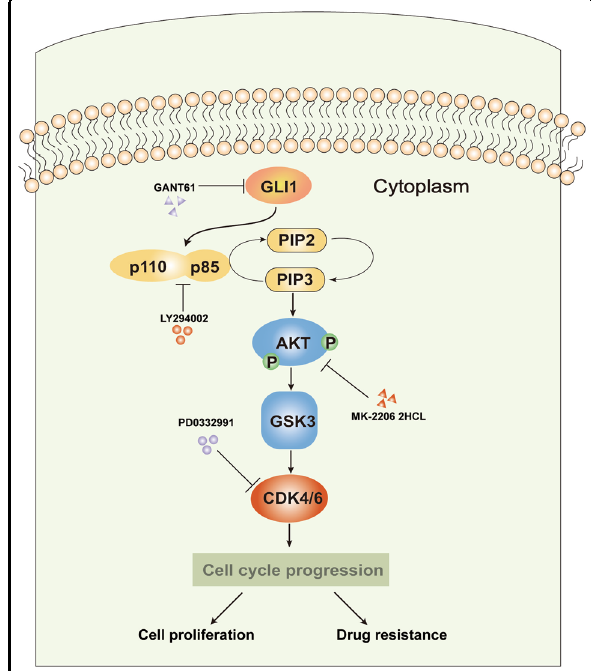
Fig. 7 Schematic drawing of the mechanism by which GLI1 regulates cell proliferation and drug sensitivity in AML. GLI1, a representative transcription factor in the Hedgehog (Hh) signaling pathway, directly activates PI3K/AKT pathway and subsequently up- regulates CDK4/6 protein through regulating